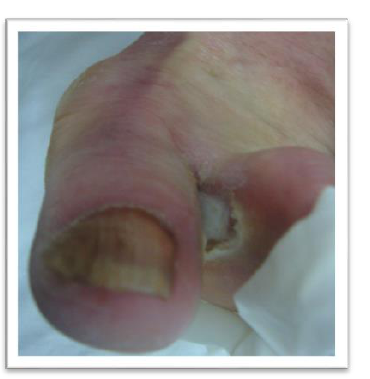
FIGURE 19 : Candida albicans on :